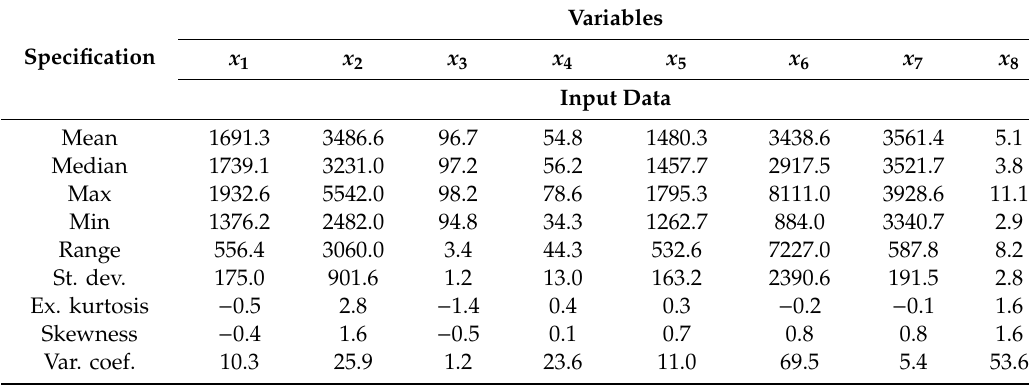
Table 4. Descriptive statistics of the variables of LAUs at the sub-regional